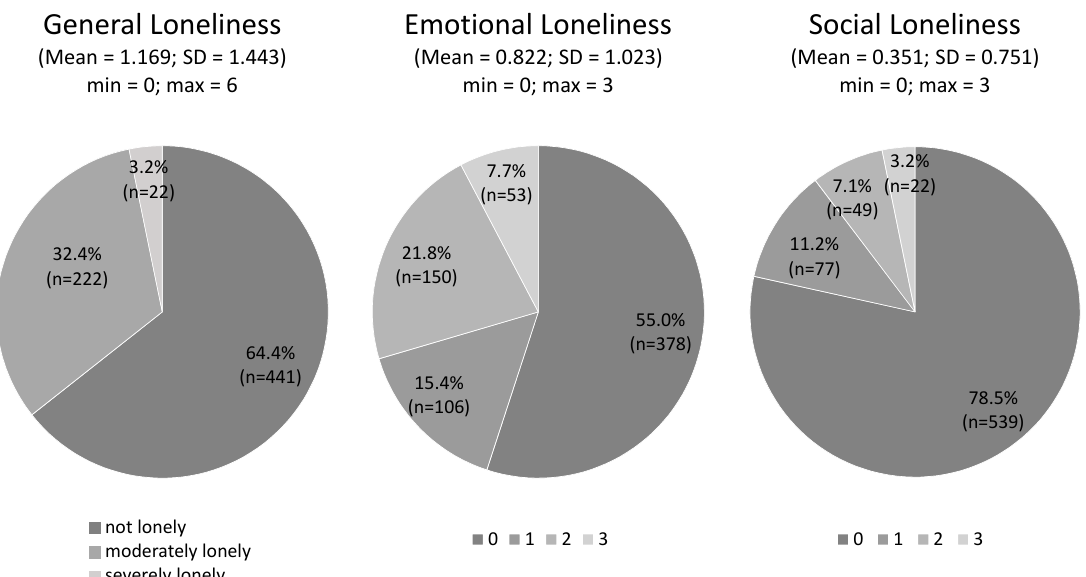
Figure 1. Loneliness in university students in